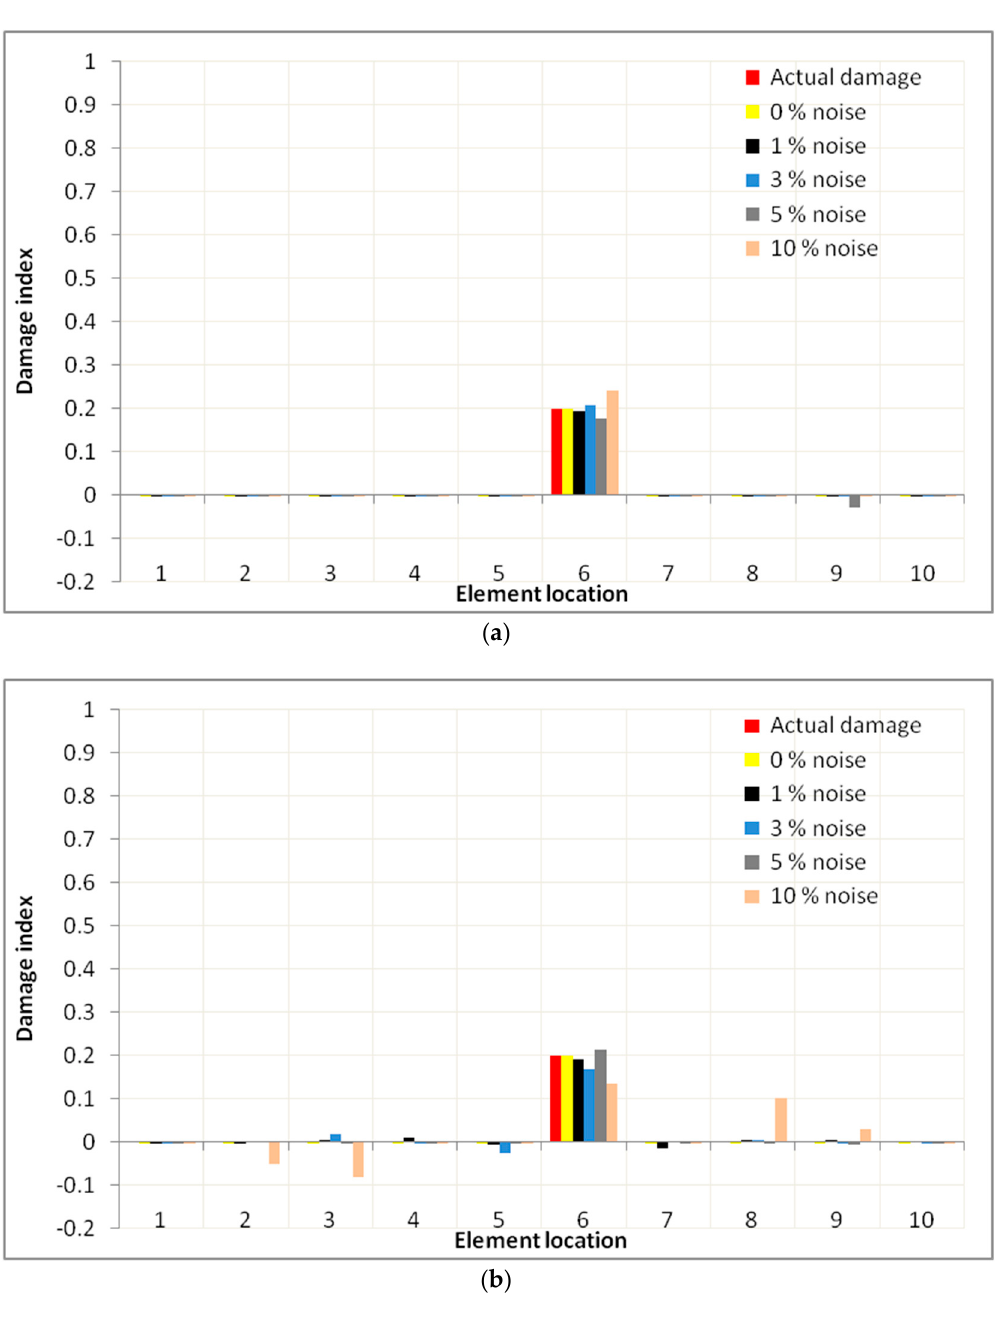
Figure 6. Damage distribution for Case 1 using Objective Function I with regularization for ( a ) noise both in frequency and mode shapes and ( b ) noise in mode shapes only.